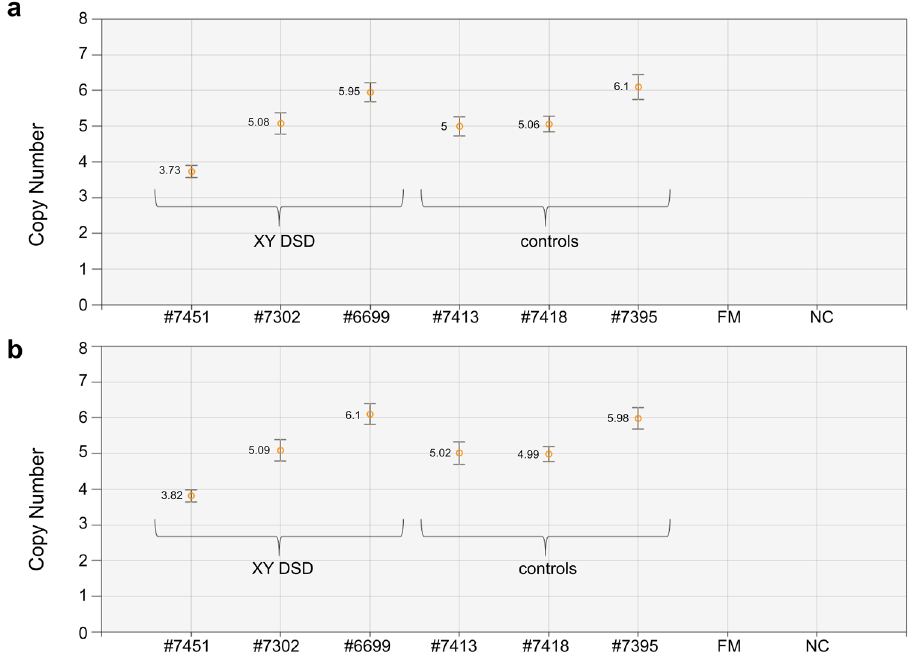
Figure 4. Variability of SRY copy number in XY DSD and control cats: ( a ) assay targeting SRY coding sequence; ( b ) assay targeting 5 ′ -flanking region of SRY . FM: control female; NC: negative control.